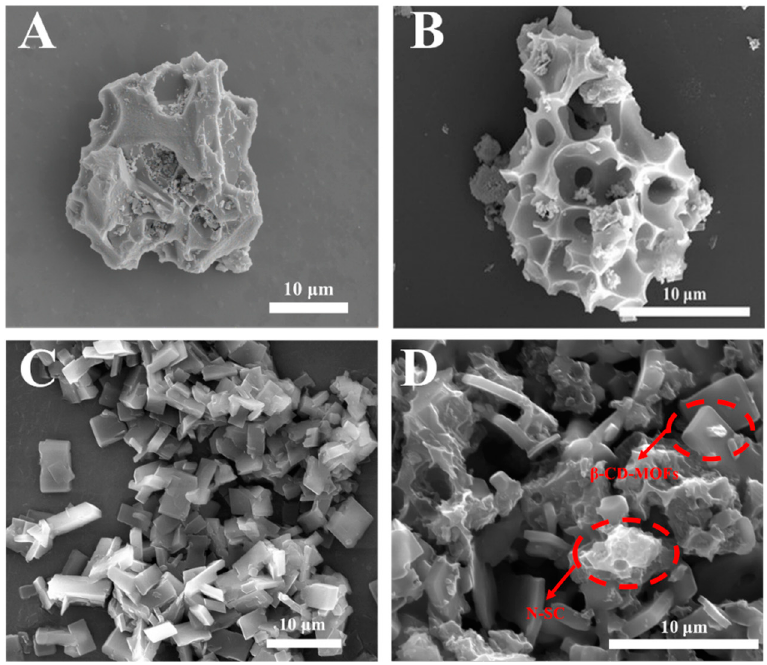
Figure 1. SEM images of NKSC ( A ), N-SC ( B ), β -CD-MOFs ( C ), and N-SC/ β -CD-MOFs ( D